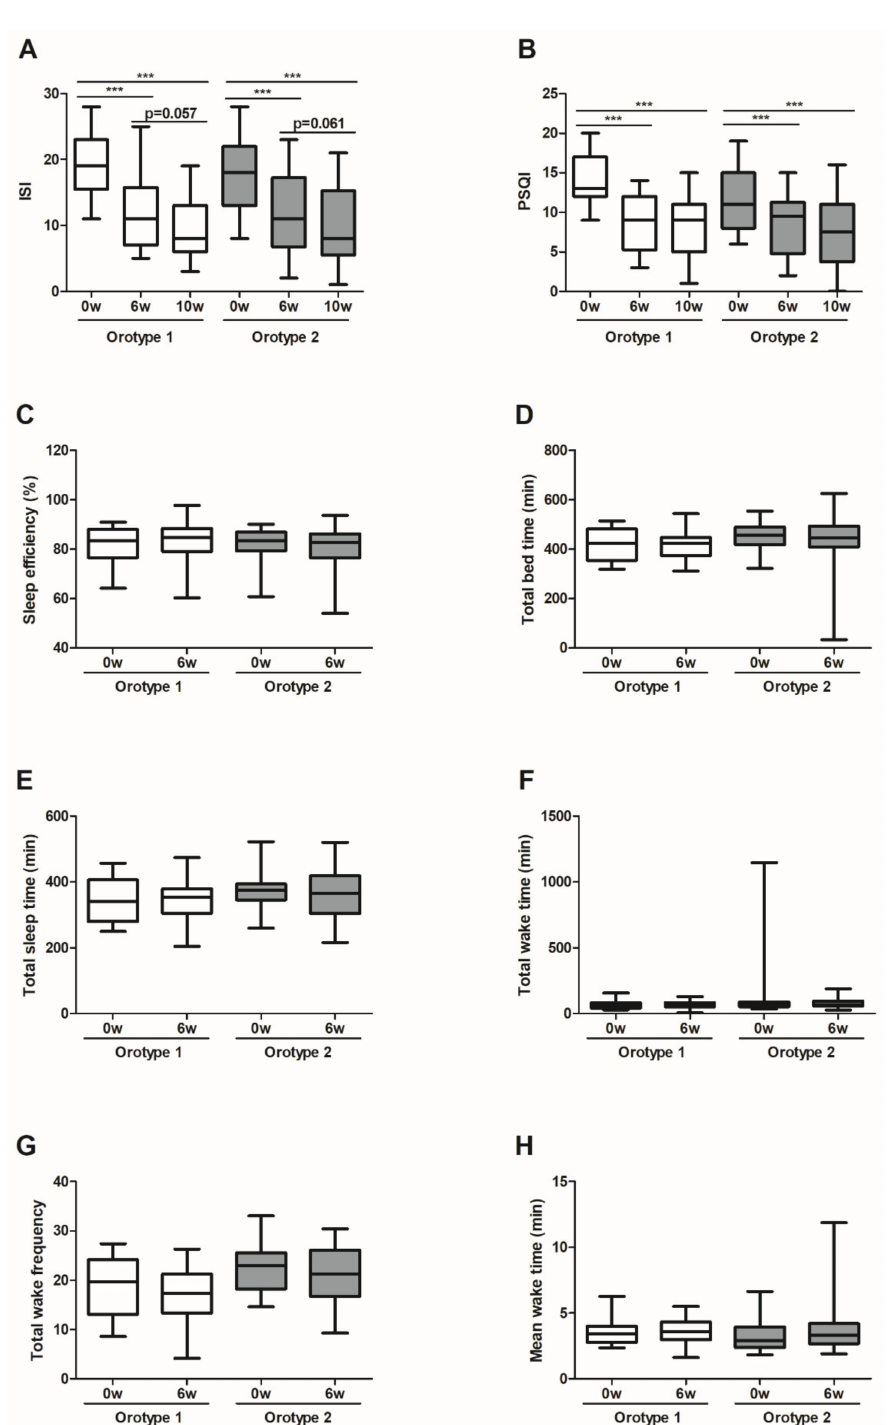
Figure 7. Effects of CWBSD on sleep quality by oral microbiota type. Changes in ( A ) ISI, ( B ) PSQI, ( C ) sleep efficiency, ( D ) total bedtime, ( E ) total sleep time, ( F ) total wake time, ( G ) total wake frequency, and ( H ) mean wake time after 6 weeks of CWBSD administration. The lines, boxes, and whiskers in the box plots represent the median (50th percentile), 25th and 75th percentiles, and the minimum-to-maximum distribution of replicate values, respectively (*** p < 0.001). ISI: Insomnia Severity Index; PSQI: Pittsburgh Sleep Quality Index; CWBSD: